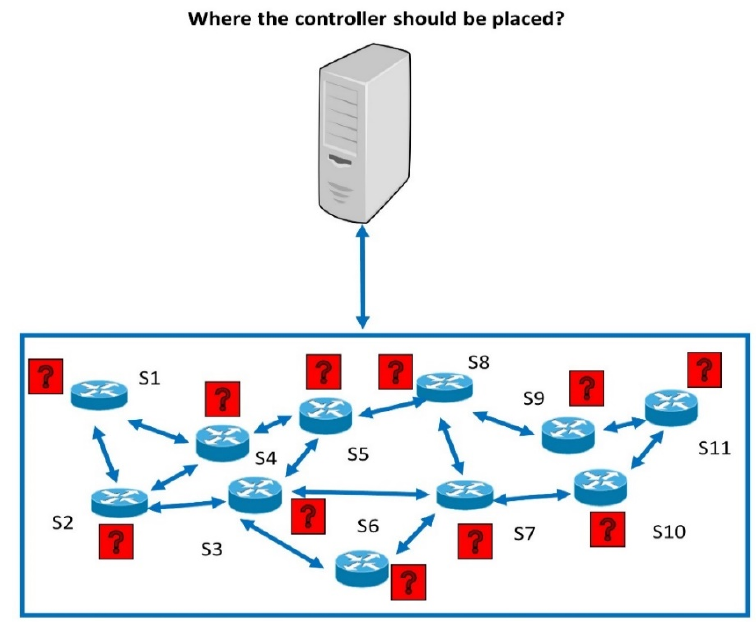
Figure 3. The controller placement effect on the QoS.